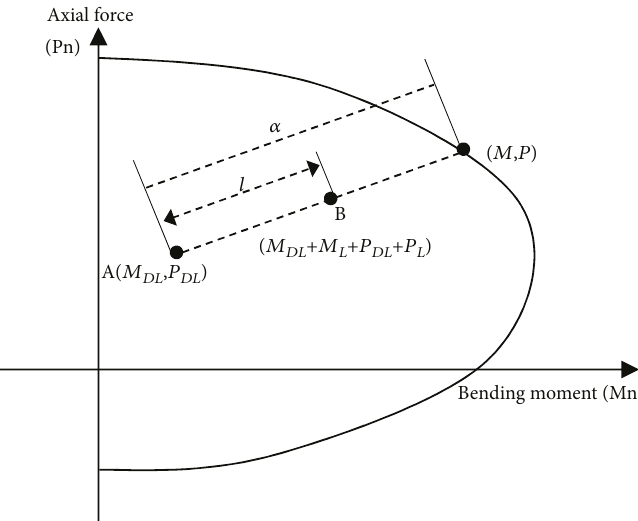
Figure 3: Axial force-bending moment